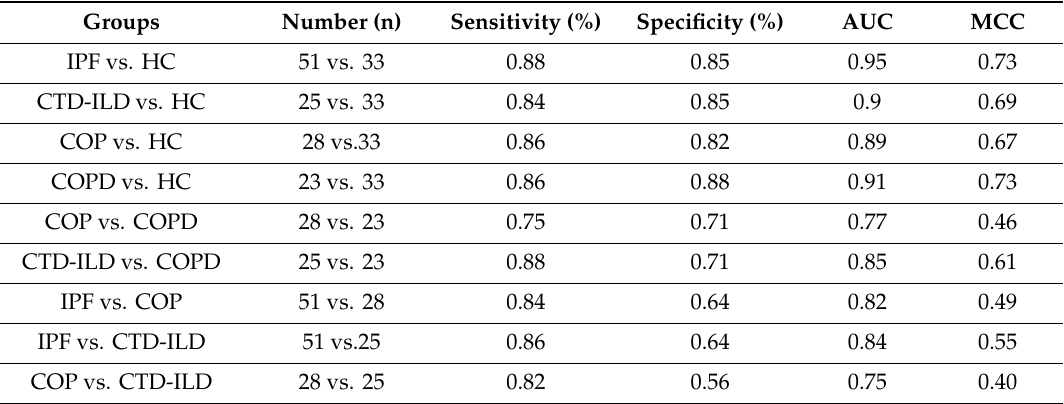
Abbreviations: AUC-area under the curve, CI-confidence interval, MCC-Matthews’s correlation coe ffi cient, CTD-ILD-connective-tissue diseases- associated ILD, COP-cryptogenic organizing pneumonia, COPD-chronic obstructive pulmonary disease, and IPF-Idiopathic pulmonary